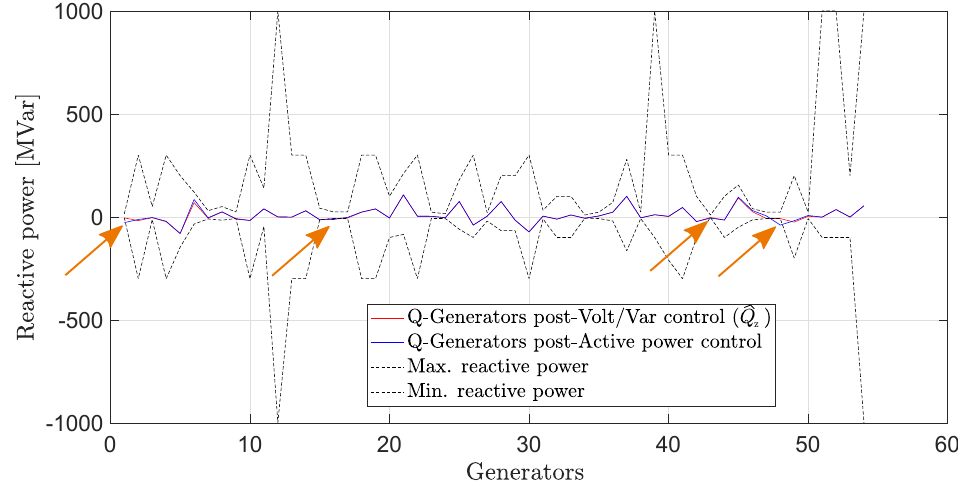
Figure 11. Results of the Volt/Var control − Reactive power set-points of